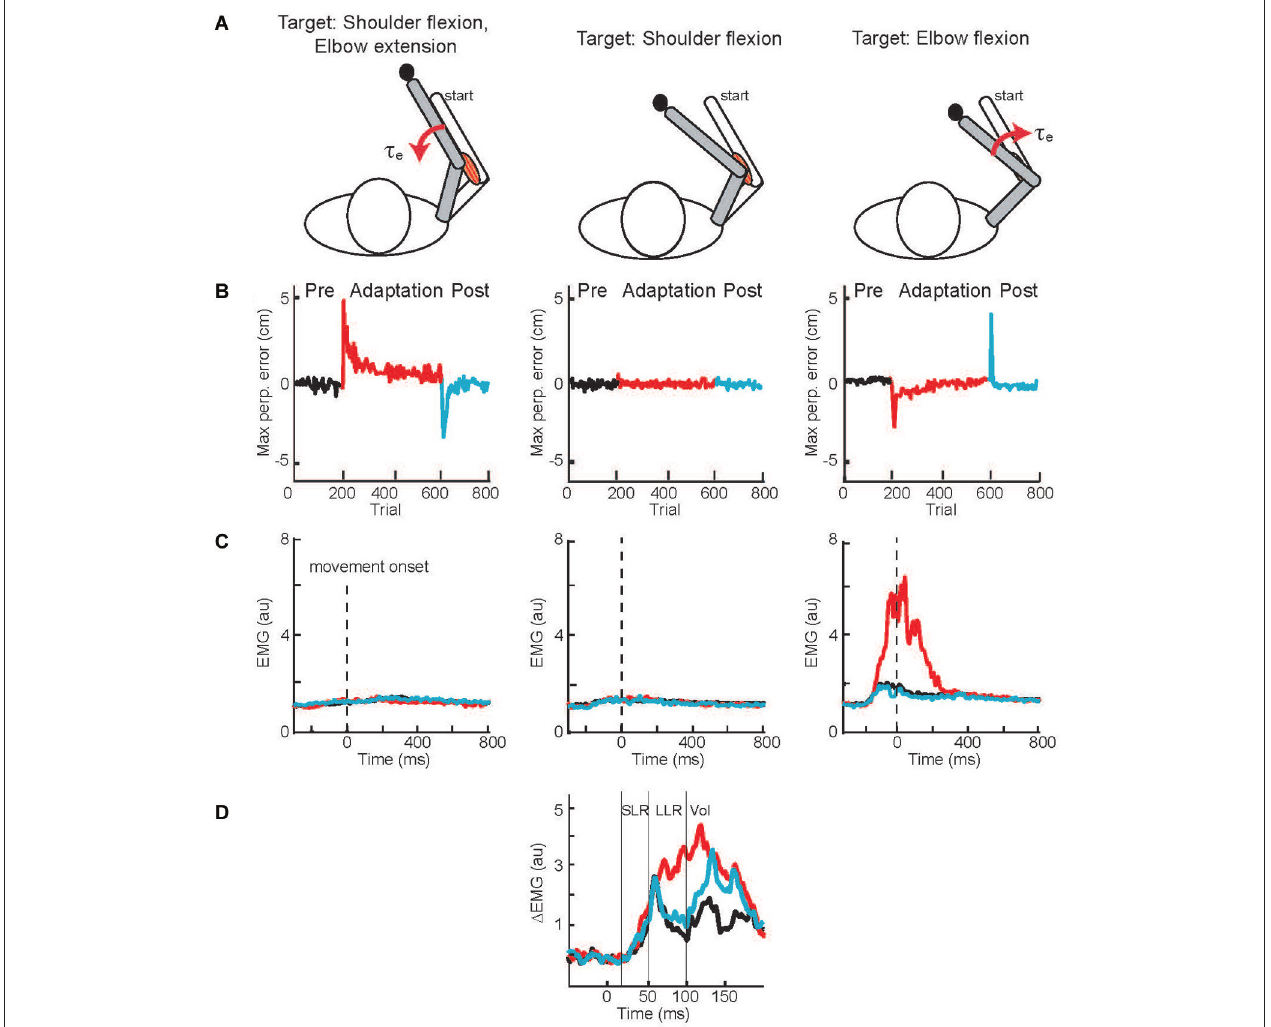
FIGURE 4 | Applied joint torques and joint motion to test adaptation of LLRs. (A) Configuration of the arm at the starting position and at the final position when reaching to three targets. A force field applied loads which resisted elbow motion, torque proportional to elbow velocity. The target on the left required shoulder flexion and elbow extension; a resistive load at the elbow applied a flexion torque. The target in the middle only required shoulder flexion; there was no load applied to the elbow as there was no elbow motion. The target on the right required elbow flexion; a resistive load at the elbow applied an extension torque.